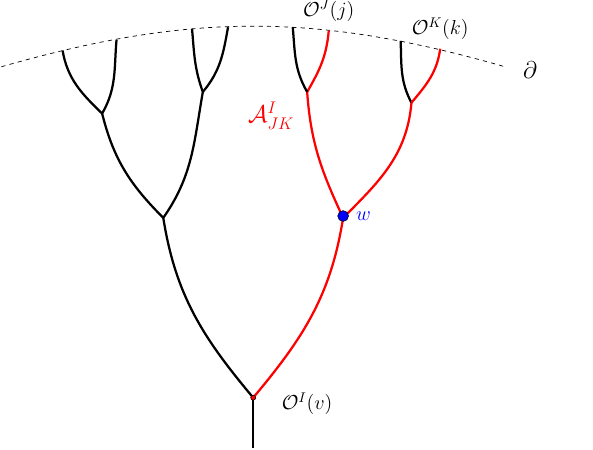
Figure 10. Non-linear contribution of global operator pushing for a tree tensor